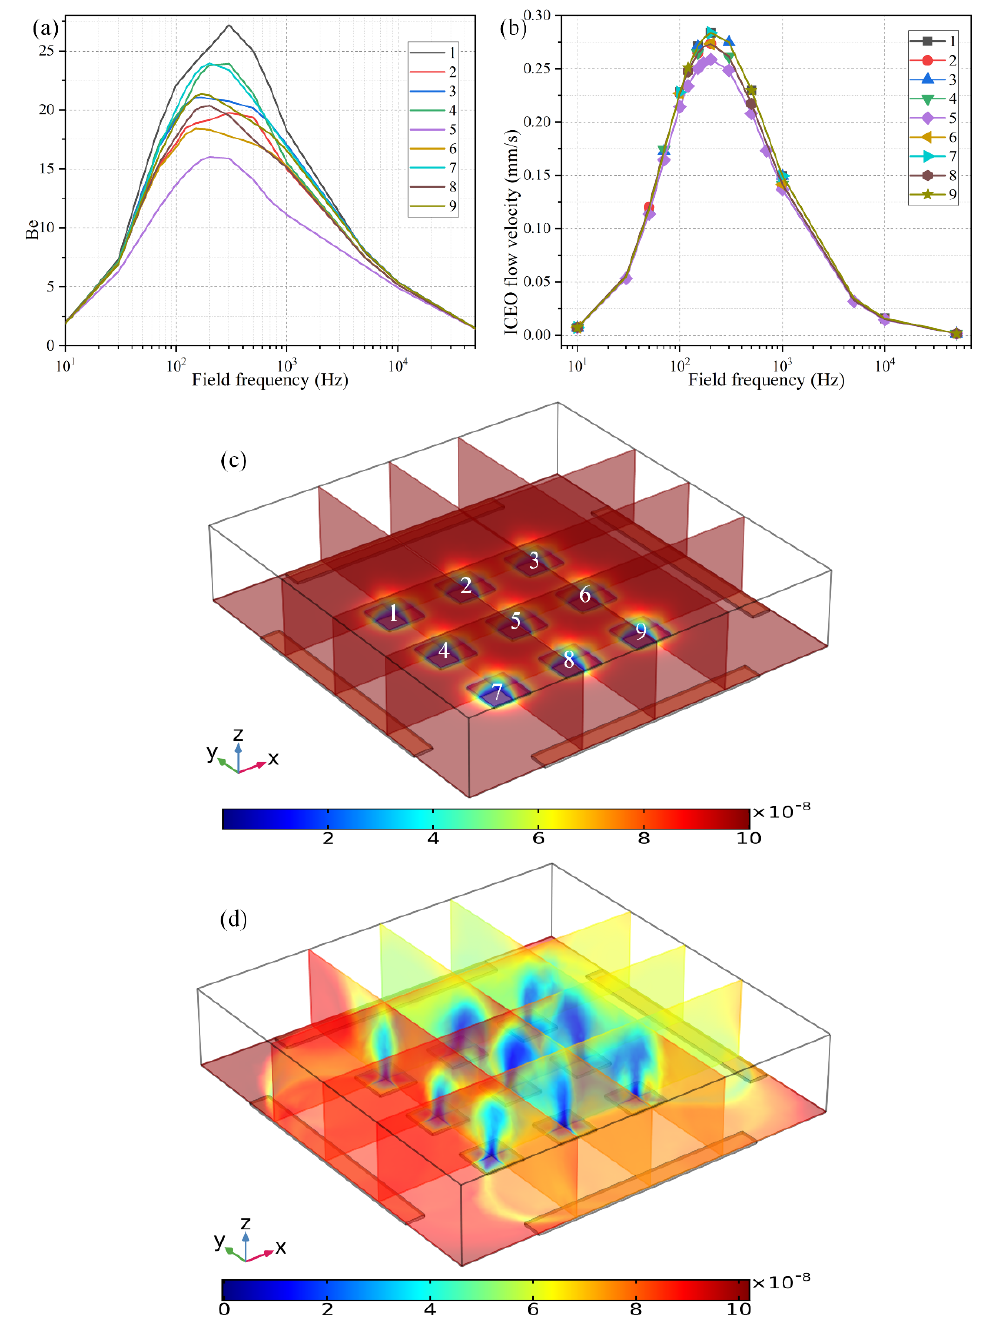
Figure 9. The effect of the number of FE in the discrete electrode arrangement on the degree of binding reaction improvement when the voltage amplitude of the applied rotating electric fields is V 0 = 4V. ( a ) The binding enhancement factor Be on each electrode in the FE array versus AC signals of different field frequencies at t = 100 s. ( b ) Frequency-dependent ROT-ICEO slipping velocity on each electrode in the FE array. ( c ) Multiple cross-sectional plots of the suspended antigen concentration with no external voltage supply at t = 100 s. ( d ) Multiple cross-sectional plots of the suspended antigen concentration at t = 100 s with an imposed rotating electric field at V 0 = 4 V and f = 200 Hz.